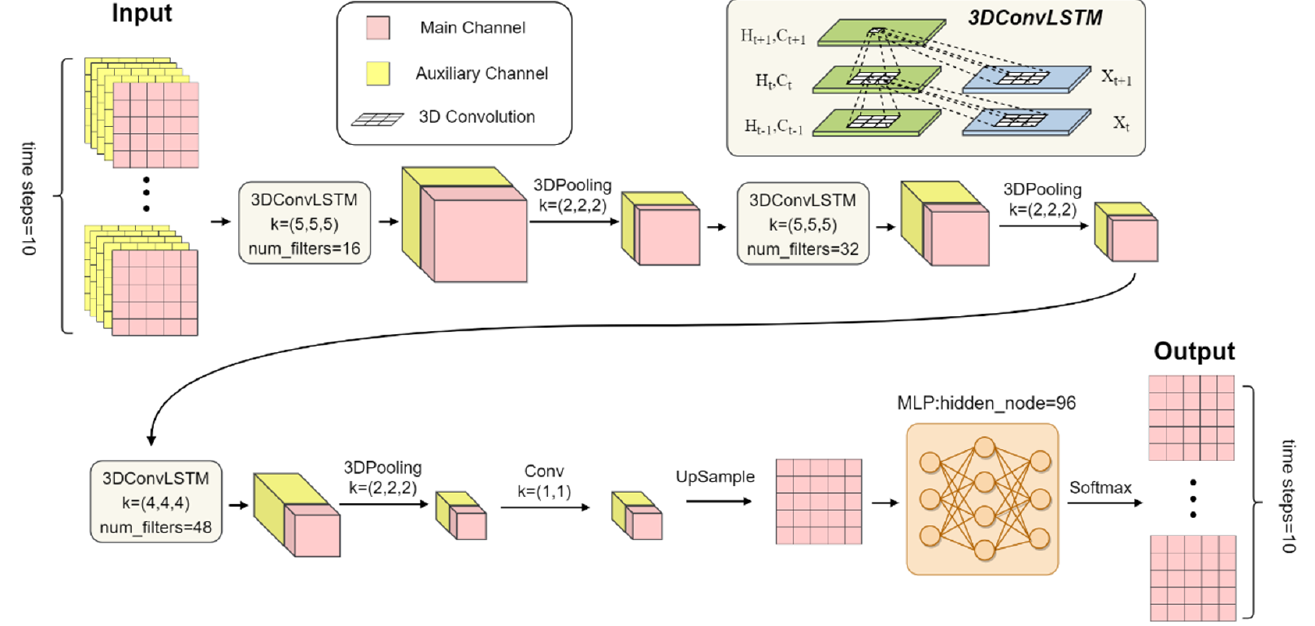
Figure 2. MS − ConvLSTM model structure diagram. Figure 2. MS-ConvLSTM model structure